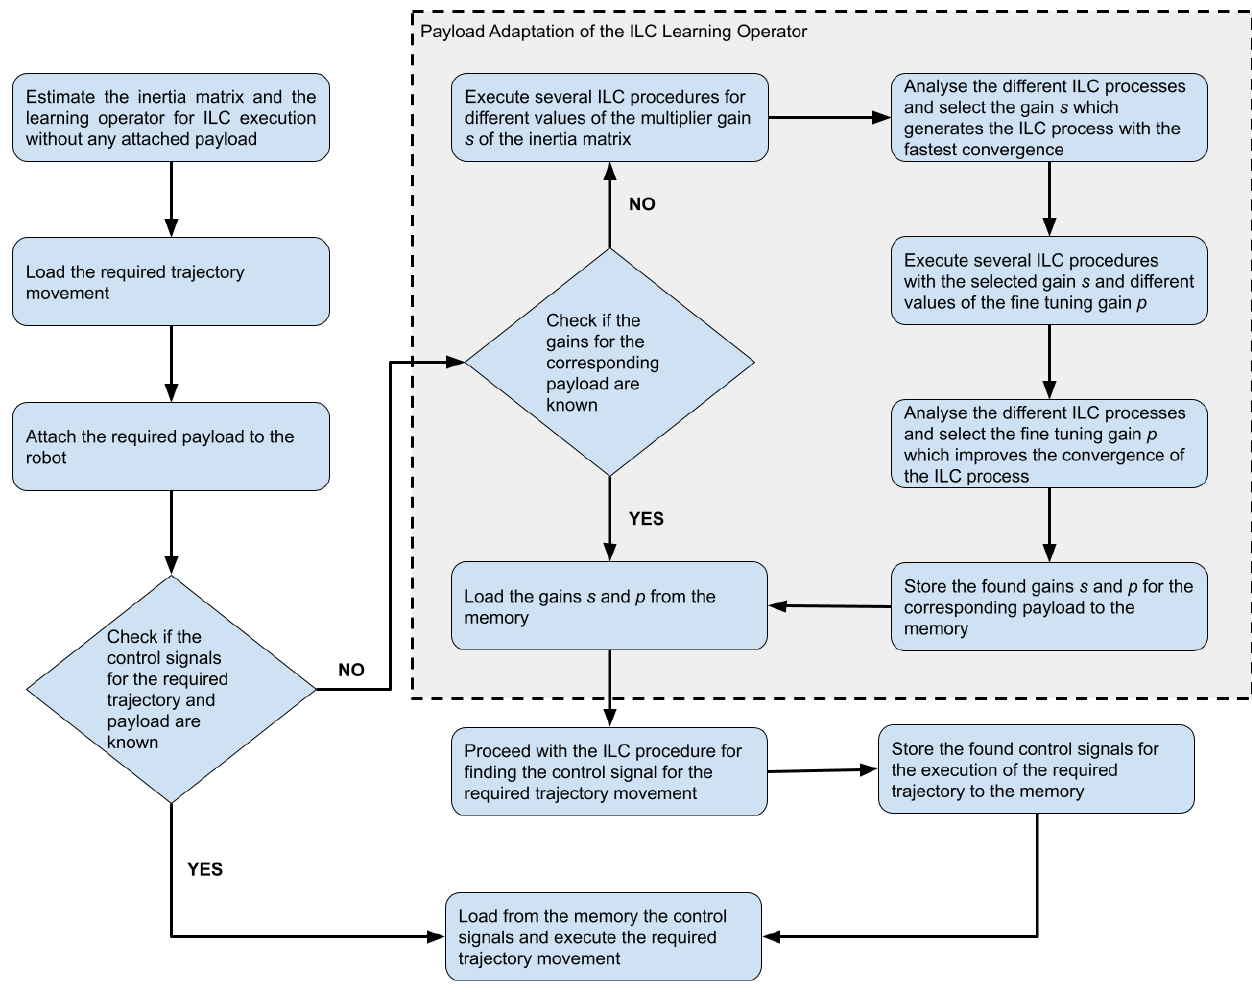
Figure 3. Schematics of the workflow of the payload-adaptive